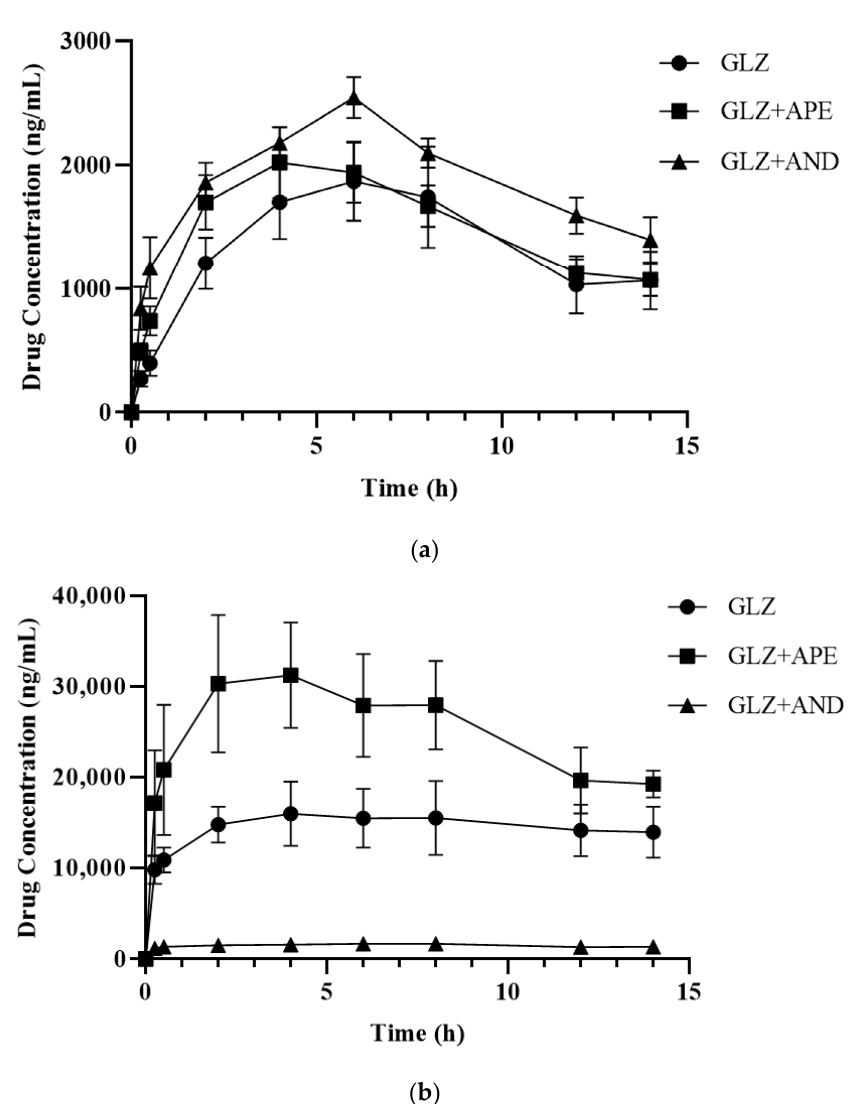
Figure 3. Concentrations of glipizide in the plasma (ng/mL ± S.E.M.) of normal ( a ) and diabetic ( b ) rats treated with glipizide (GLZ 5 mg/kg BW) alone or in combination with Andrographis paniculata extract (APE 300 mg/kg BW) and andrographolide (AND 15 mg/kg BW). Table 6. Pharmacokinetic parameters of glipizide in the plasma of normal and diabetic rats.